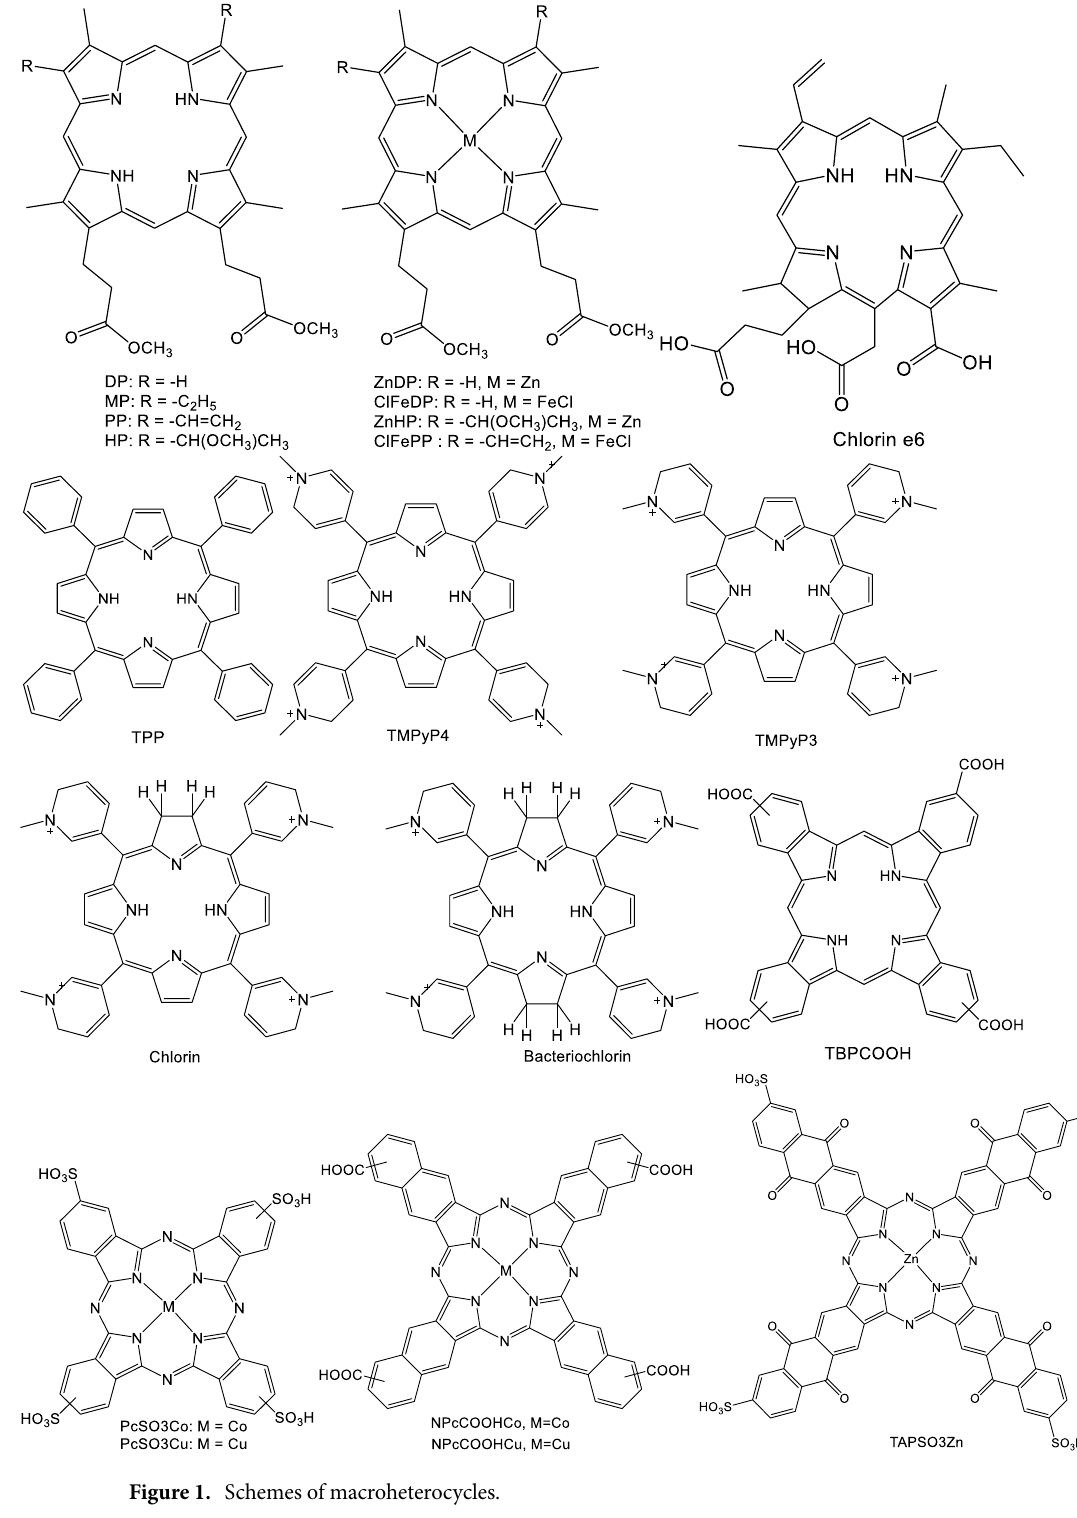
Figure 1. Schemes of